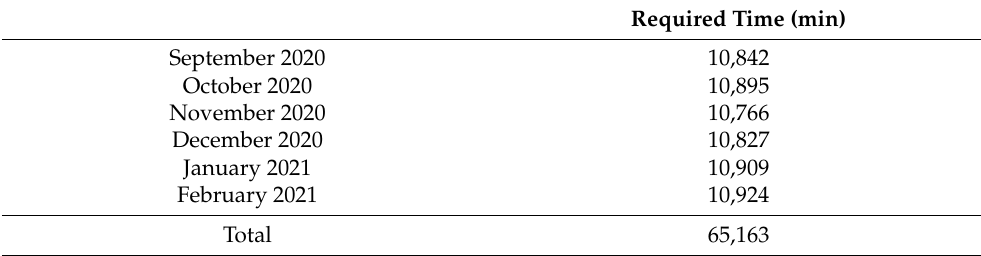
Table 6. Daily working time required to do the same amount of work after using the DT.